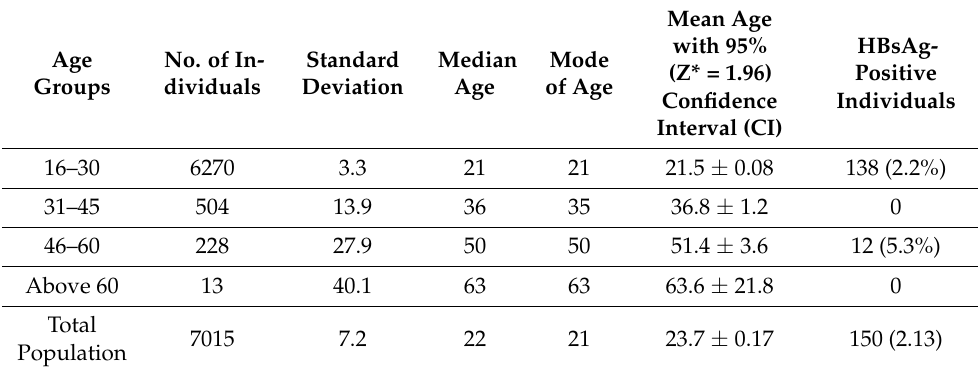
Table 2. Prevalence of hepatitis B in different age groups is shown in the table. Age No. of Groups